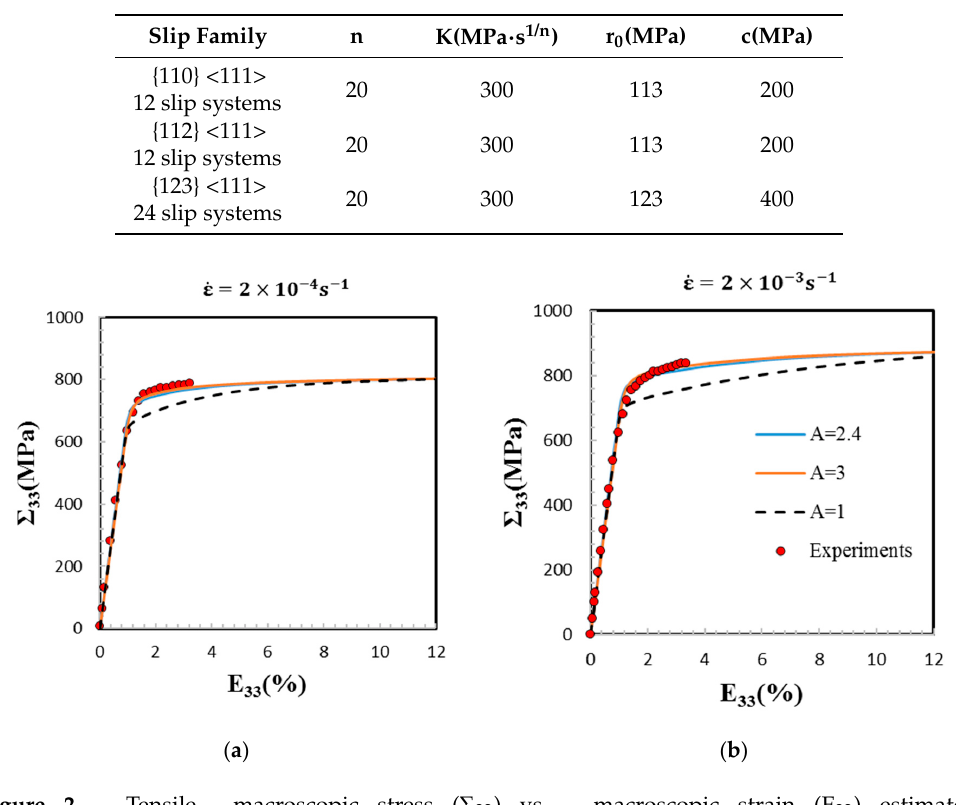
Figure 2. Tensile macroscopic stress ( Σ 33 ) vs. macroscopic strain (E 33 ) estimated by the Affine elasto- viscoplastic self-consistent model (EVPSC) model at two strain rates: 2×10 -4 s -1 ( a ) and 2×10 -3 s -1 ( b ) using three anisotropy factors (A). The numerical results are compared to the experimental data provided in [4,21] (red circles). For the calculations, an equiaxed β microstructure with random texture is considered.